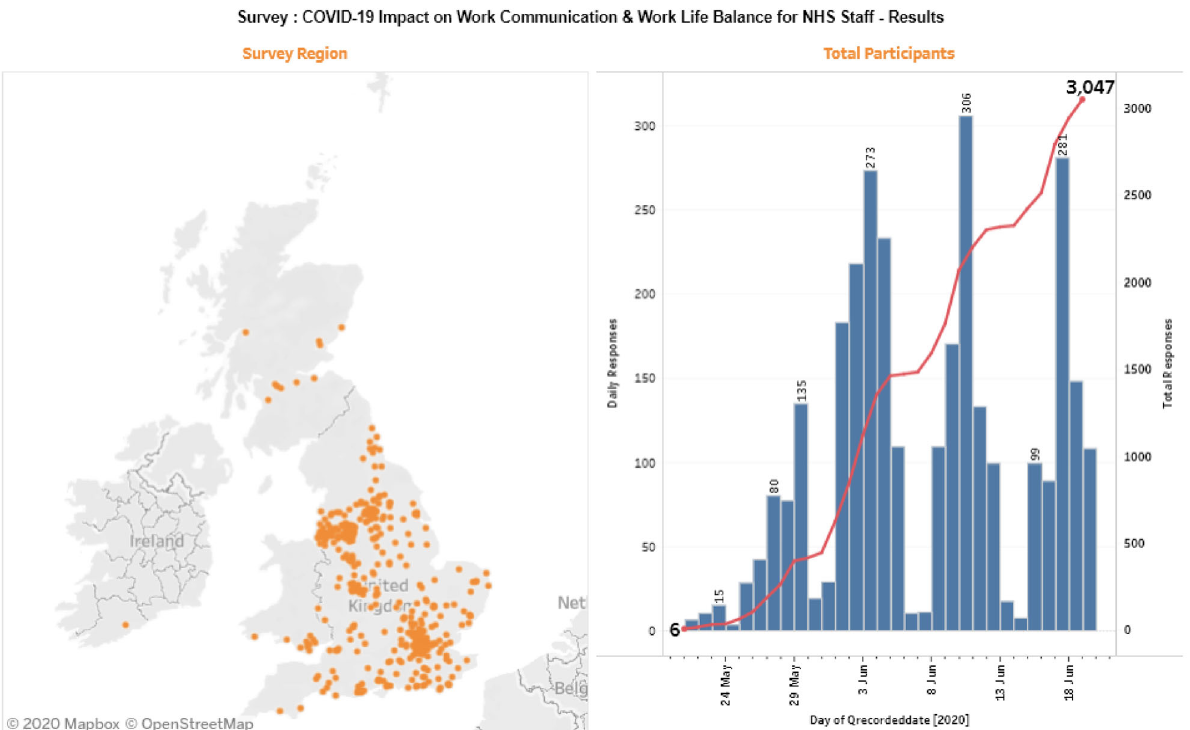
Fig. 1 Figure showing survey accruals and geolocation of survey respondents. First panel showing geolocation in orange. Second panel showing accruals in blue and totals in red over the time